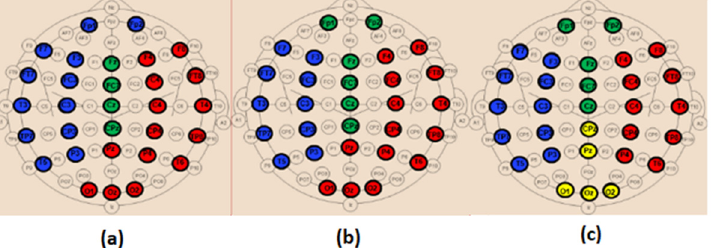
Figure 14. The distribution of the nodes in each module in the beta band for the ( a ) SCI, ( b ) MCI and ( c ) AD groups.